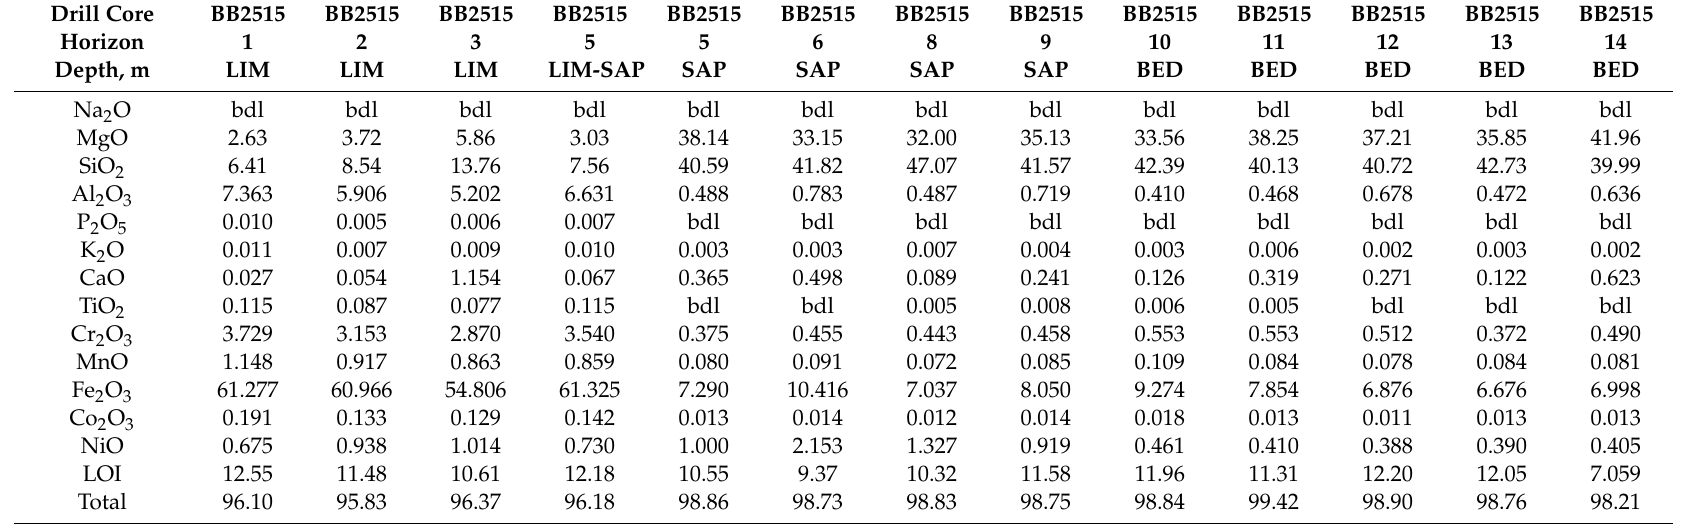
Table 7. Whole-rock chemical analyses (wt%) of the bedrock (BED), saprolite (SAP), and limonite (LIM) samples through BB2515